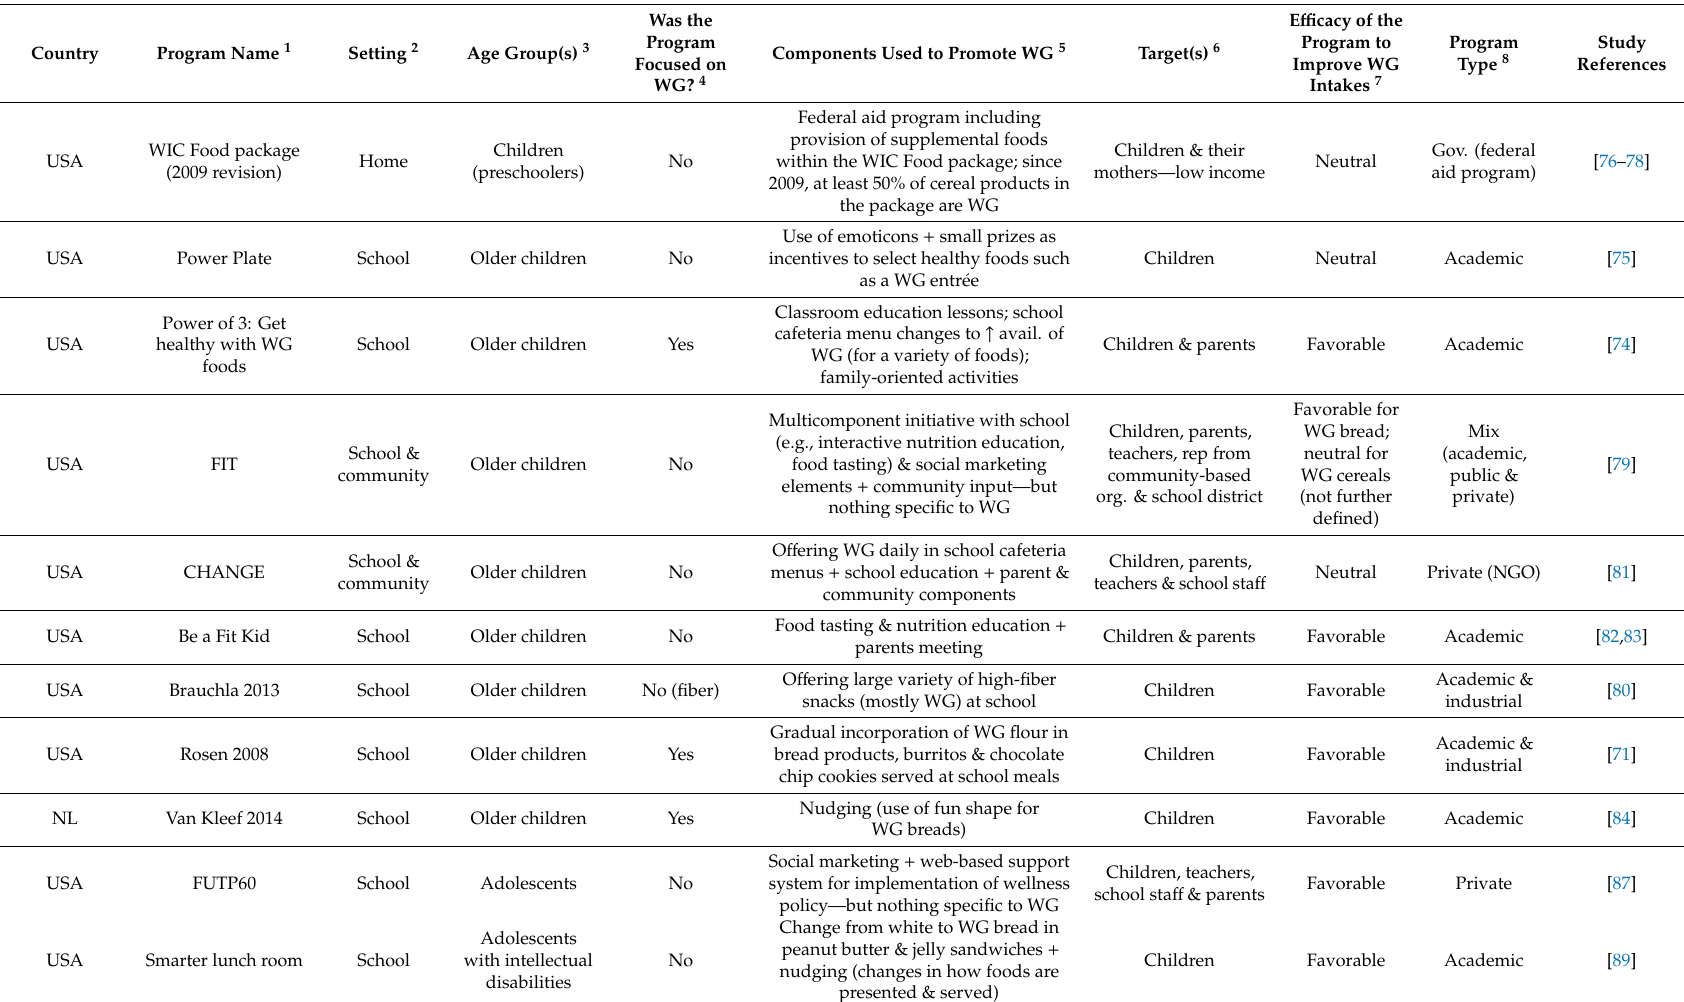
Table 2. Description of programs that aimed at promoting the consumption of whole grains in children and adolescents, as identified in the frame of the current review.